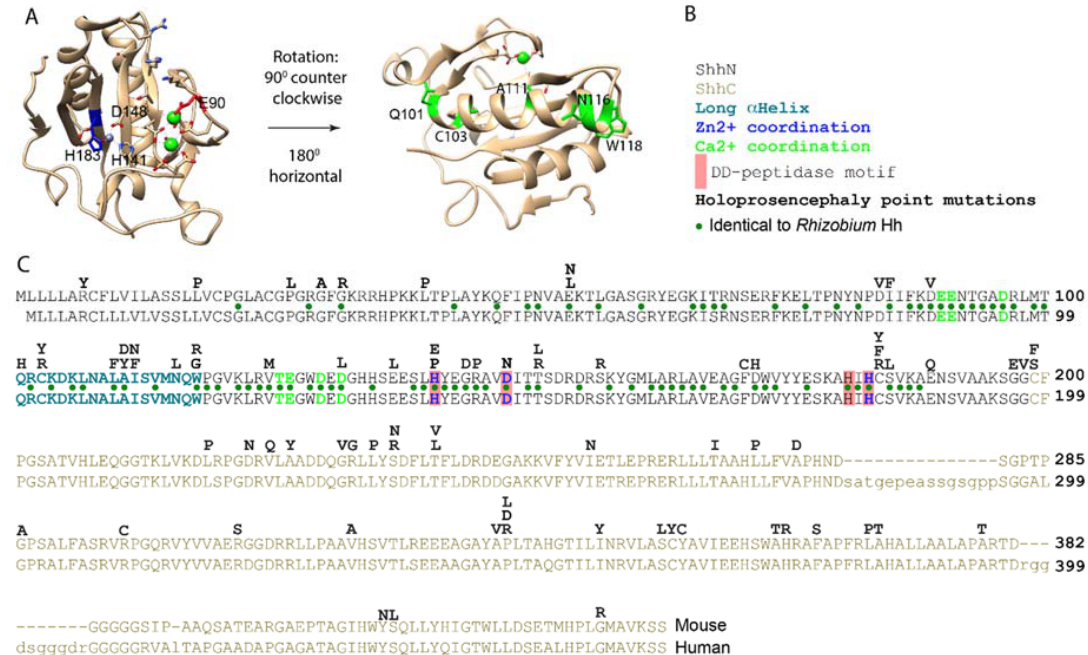
Figure 2. Salient features of the Shh protein. ( A ) Crystal structure of ShhN. The Zn 2+ (steel) and Ca 2+ (green) coordination domains are indicated. Residues in the large α -helix mutated in holoprosencephaly are labeled in green. ( B ) Legend. ( C ) Lineup of mouse Shh (top) and human (bottom) Shh. Point mutations resulting in single amino acid changes in Shh found in holoprosencephalic individuals are shown above the lineup. Residues mediating Ca 2+ and Zn 2+ coordination are labeled in blue and green respectively. Green dots indicate conserved residues between Rhizobium Hh and mouse/human Shh.